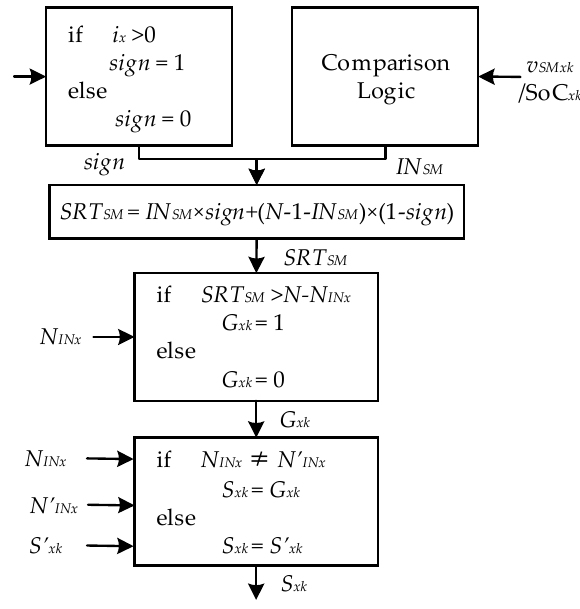
( c ) Individual SoC balancing control. Appl. Sci. 2020 , 10 , x FOR PEER REVIEW